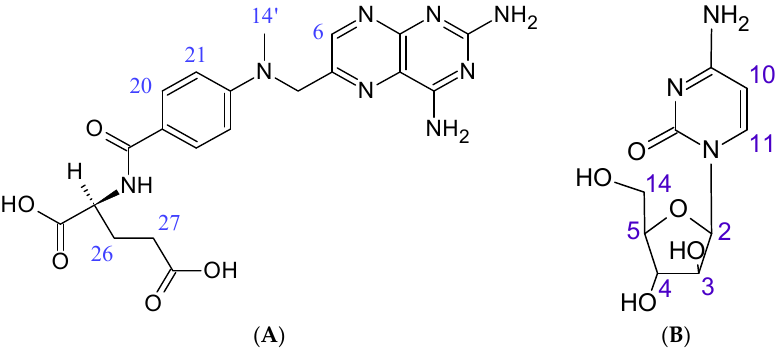
Figure 1. Chemical structures of ( A ) methotrexate; ( B ) cytarabine.